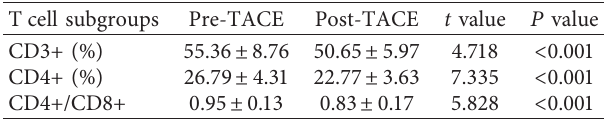
Table 1: T cell changes in patients before and after TACE. T cell subgroups